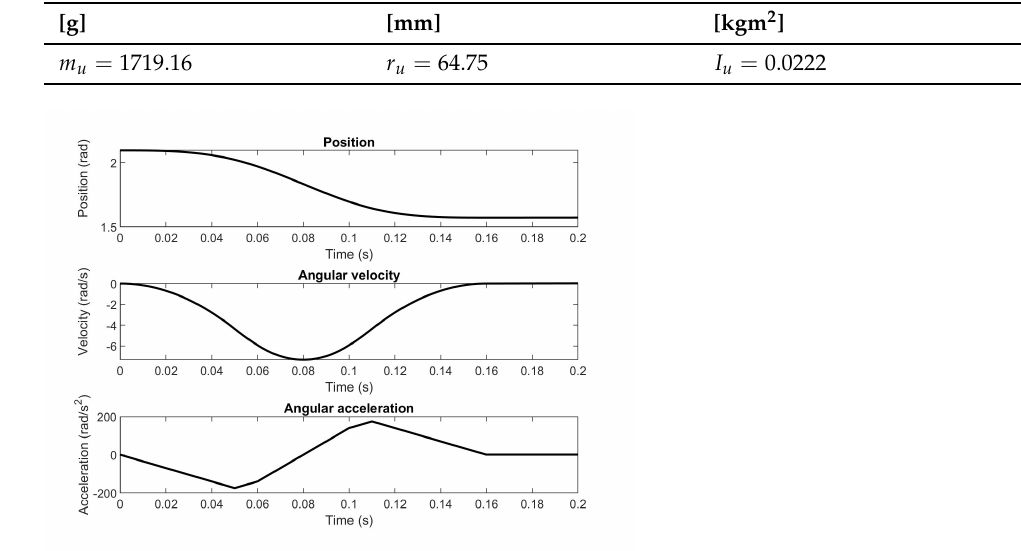
Figure 7. Reference trajectory based on the S-curve profile in which the mechanism is moved from θ 1 = 98.2 deg to θ 1 = 68.2 deg with a peak rotational acceleration of 174.5 rad/s 2